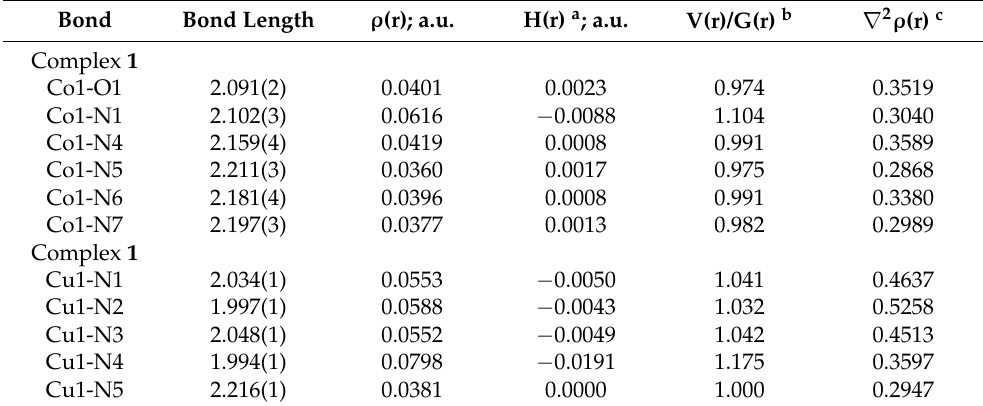
Table 8. The AIM parameters for compounds 1 and 2 .